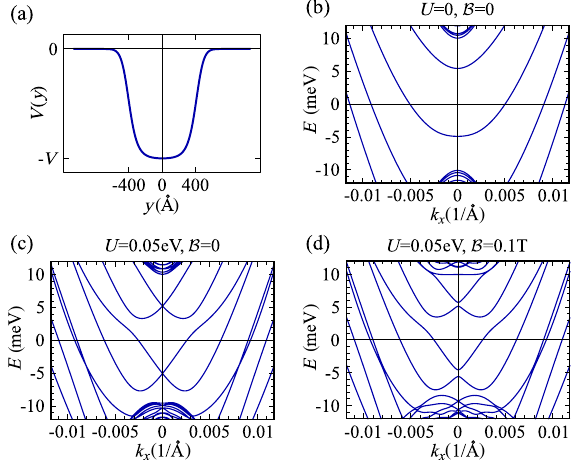
FIG. 4. (a) Smeared confinement potential used to define a wire in our numerical simulations. (b)–(d) Calculated band dispersions in various cases assuming a d ¼ 70 - (cid:5)A -thick quantum well, wire width W ¼ 800 (cid:5)A , and confinement potential depth V ¼ 0 : 052 eV . In (b) U ¼ B ¼ 0 so that both the Rashba coupling and the magnetic field are absent. A voltage drop U ¼ 0 : 05 V is present in (c), leading to Rashba splitting of the confined bands. A magnetic field separates the Rashba-split bands, as (d) illustrates for a perpendicular field of strength B ¼ 0 : 1 T . Dense bands at the top and bottom of these plots represent extended bulk